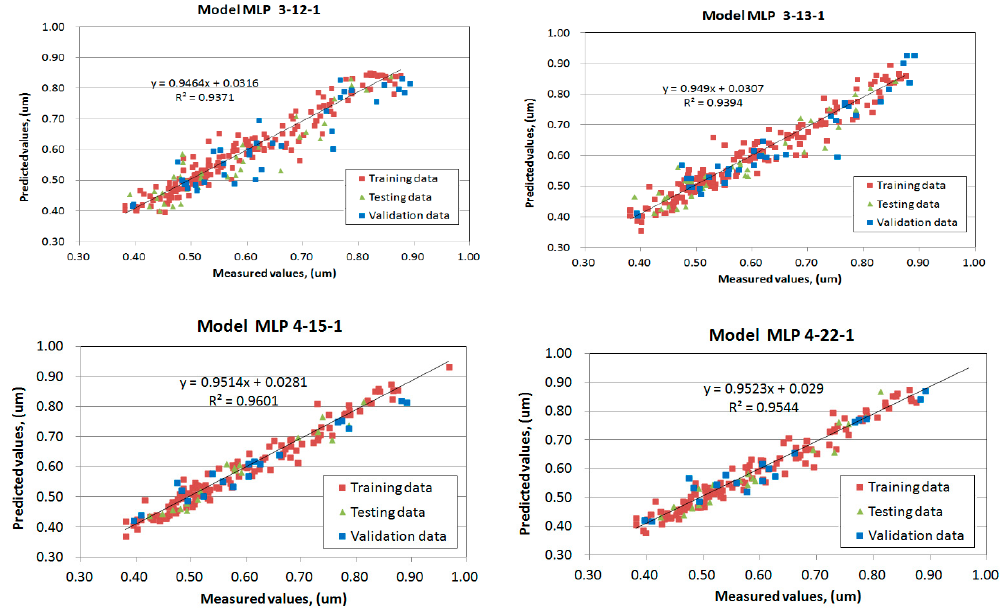
Figure 13. Comparison of the target and output values of the surface roughness for all data.